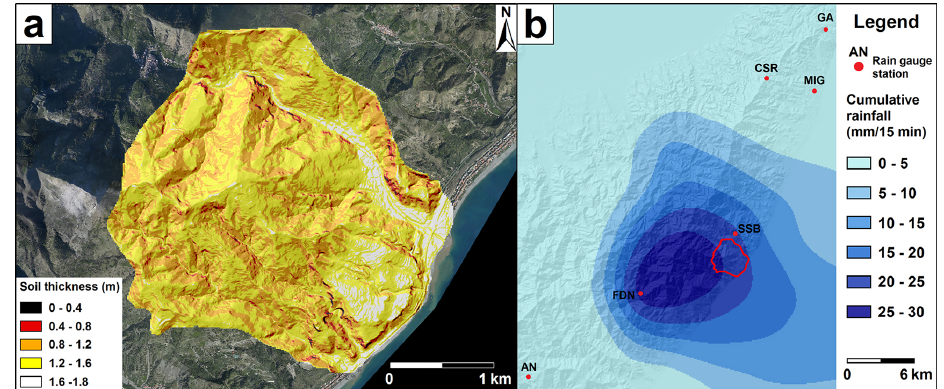
Figure 7. (a) Soil thickness map for the study area; (b) an example of rainfall map resulting from the application of the conditional merging technique: in this case, the cumulative rainfall between 17:00 and 17:15UTC is reported. Points indicate the location of the six rain gauge stations used in the method (AN: Antillo, CSR: Colle San Rizzo, FDN: Fiumedinisi, GA: Ganzirri, MIG: Messina Istituto Geofisico and SSB: Santo Stefano di